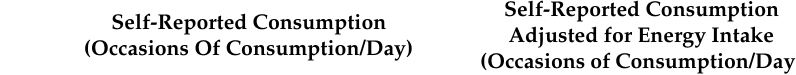
Table 5. Associations between fat taste thresholds and frequency of food group consumption as reported by the Food Frequency Questionnaire